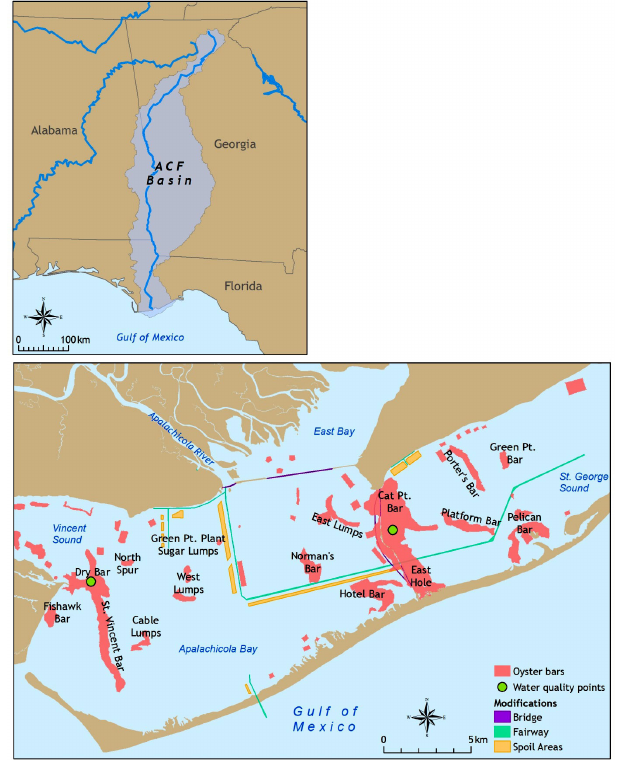
Fig. 1 . Map of Apalachicola Bay, showing the location where the Apalachicola River enters the bay, the barrier islands, St. George and Little George, that enclose the bay, and the major oyster ( Crassostrea virginica ) bars, including two bars that have been historically productive locations for oystering: Dry Bar at the western end of the bay and Cat Point Bar just to the east of the midsection of the